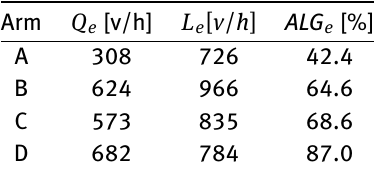
Table 4: Load factor of the entrances. Source: